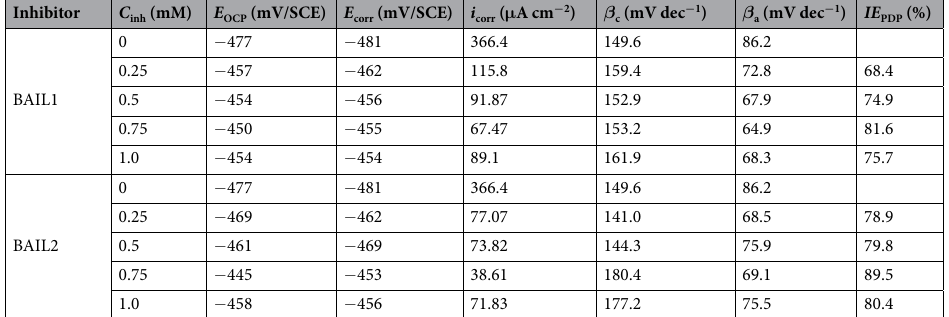
Table 2. The potentiodynamic polarization parameters for carbon steel in 0.5 M HCl solution without/with different concentrations of BAIL1 and BAIL2.